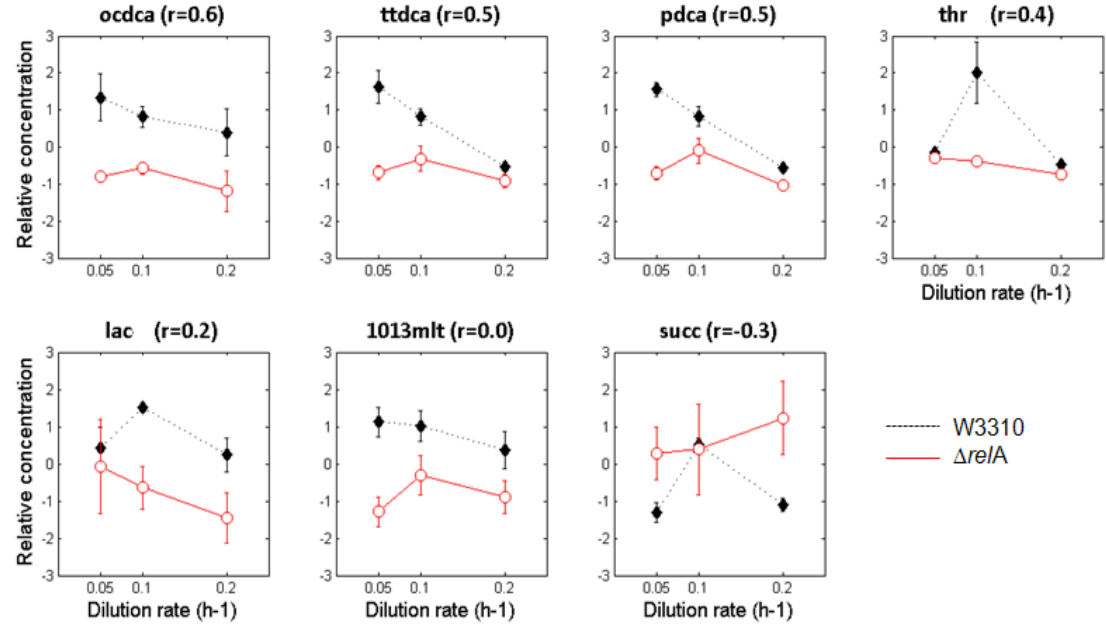
Figure 2. Metabolic patterns of the W3110 (represented by full diamonds and dashed lines) and  rel A (represented by open circles and red lines) E. coli cultures that presented low pairwise correlation coefficients ( r < 0.6). The error bars shown in the line graphs represent the relative standard deviation among the 3–4 sample replicates. Only metabolites that presented significant changes according to the Mack-Skillings test for the strain factor (factor A) were considered in this